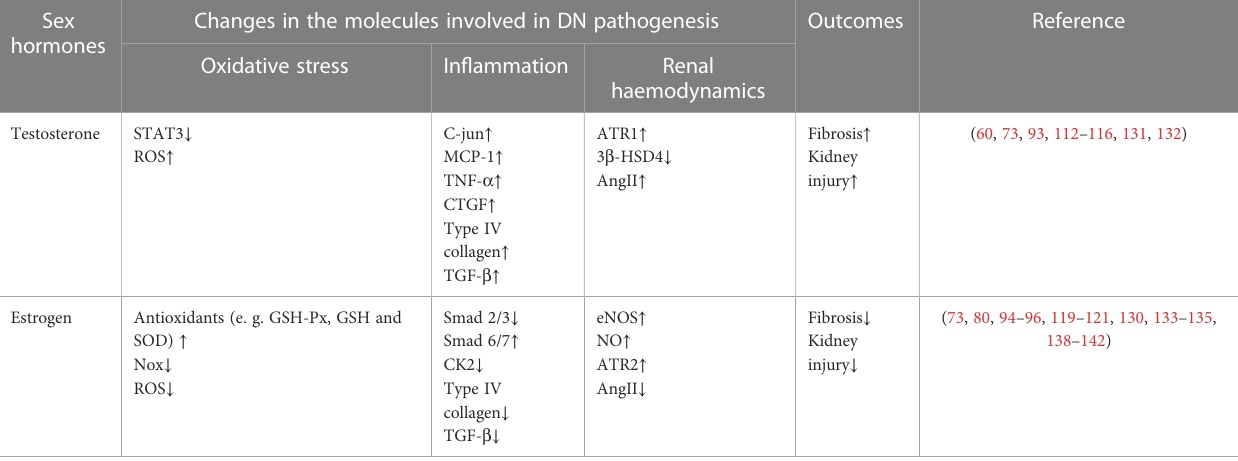
TABLE 1 Sex hormones affect the pathogenesis of DN and related molecules.